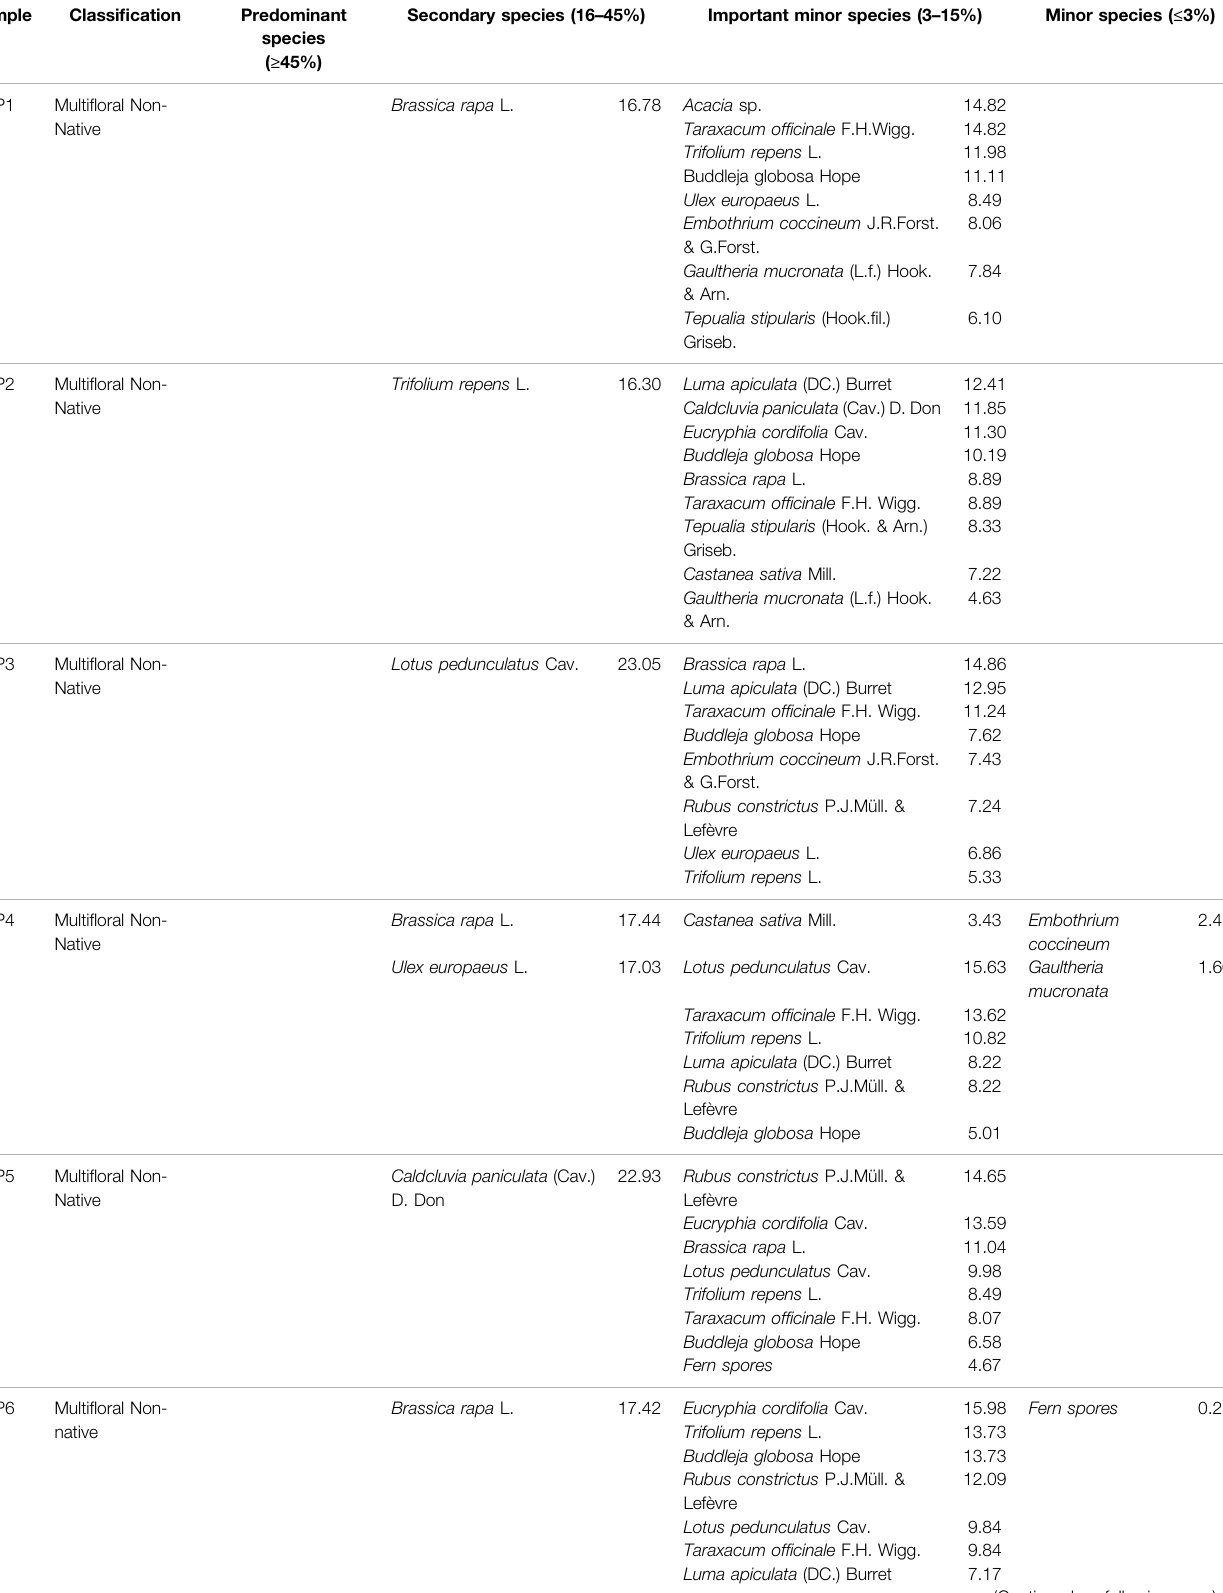
TABLE 1 | Palynological analysis of the botanical origin and classi fi cation of honeybee pollen samples (HBPs).